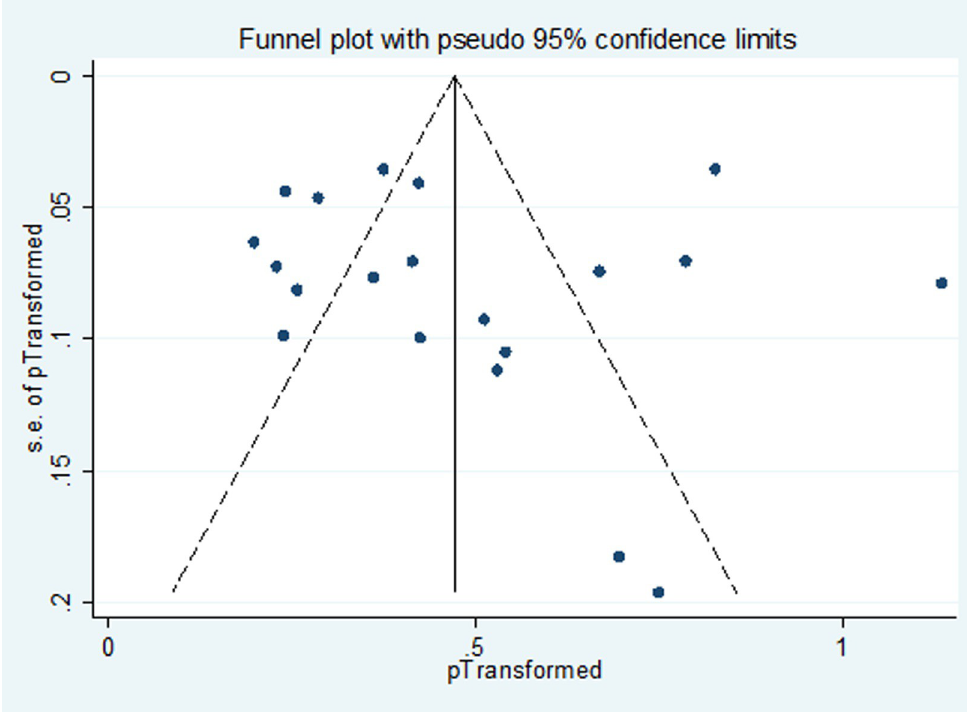
Fig 3. Funnel plot of the meta-analysis on prevalence of Nocardia